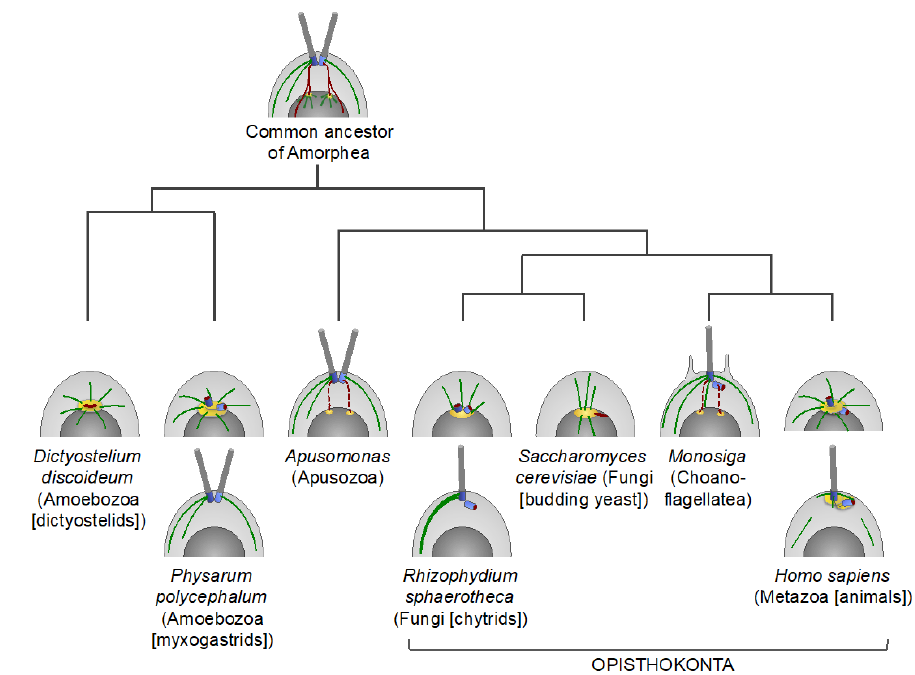
Figure 2. Centrosomes and the basal body apparatus in certain lineages of the Amorphea supergroup. A schematic illustration of cells in early interphase. Centrioles and basal bodies are in blue, flagella are in grey, microtubules (MTs) are in green, and the pericentriolar material (PCM) [which presumably originates from the ancestral nucleus-associated MT-organizing center (MTOC)] is in yellow. The ancestral centrin-containing nucleus-basal body connector and other centrin-containing structures are in red. Dashed red lines indicate that evidence of a nucleus-basal body connection is incomplete. In apusomonads, the basal bodies are connected to the nucleus with a striated fibrous root, rhizostyle, but it is unclear if it contains centrin or not [70]. In choanoflagellates, prior to cell division, the basal bodies duplicate and migrate to poles of the nucleus [71]. For Physarum polycephalum and Rhizophydium sphaerotheca , interphase cells of two di ff erent life cycle stages are shown. It is unclear if the basal bodies are surrounded by the PCM in these